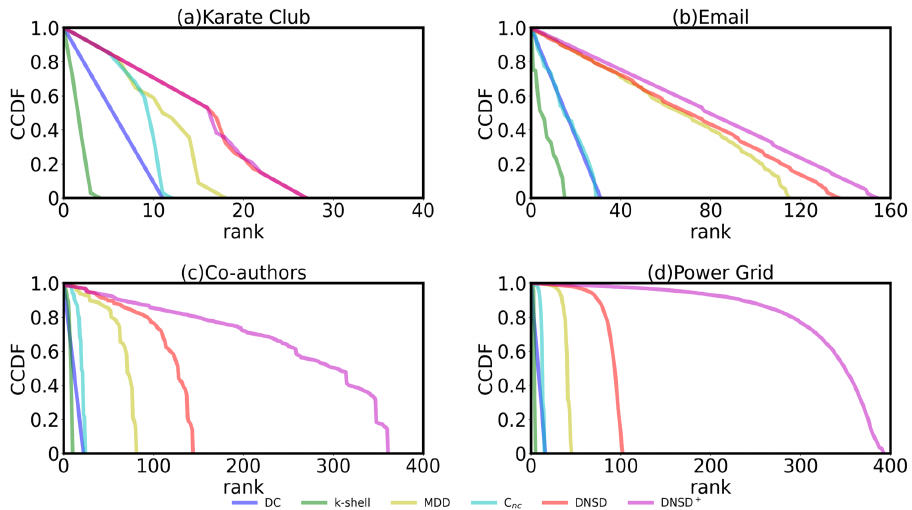
Figure 3. The complementary cumulative distribution functions (CCDF) of the rankings obtained by different methods in Karate Club, Email, Co-authors and Power Grid α is set to 0.5 and β is set to